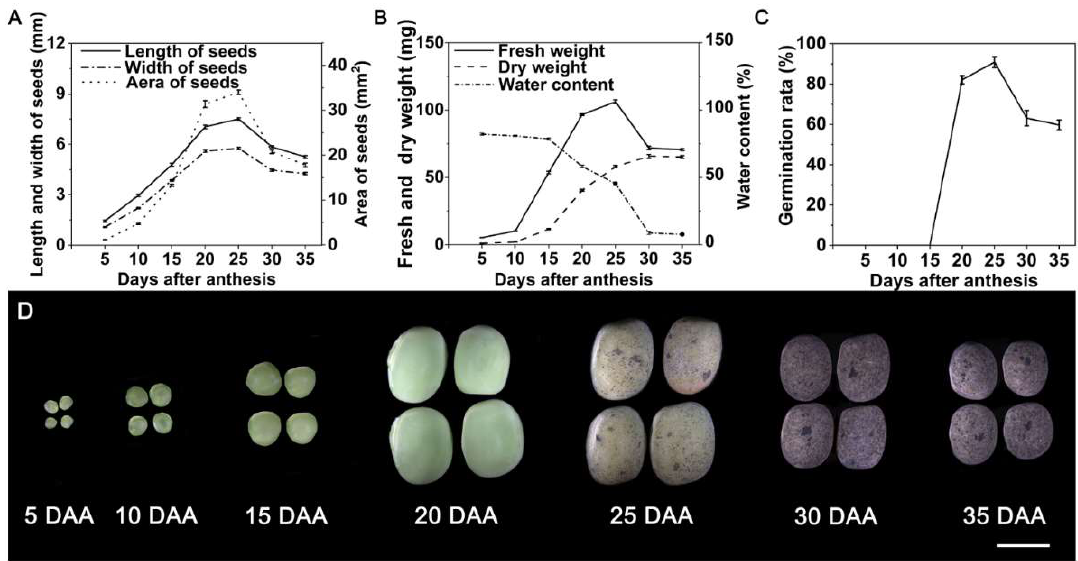
Figure 1. Morphology changes during seed development. ( A ) Changes in length, width and area of seeds. ( B ) Changes in fresh weight, dry weight and water content of seeds. ( C ) Changes in the germination rate of seeds. ( D ) Morphological changes at different developmental stages from 5 DAA to 35 DAA in the seeds of common vetch. Scale bar = 5 mm.